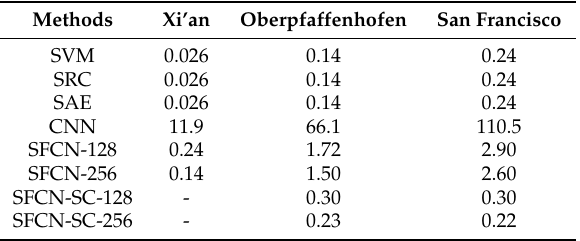
Table 8. Data memory consumed by various methods corresponding to three PolSAR images